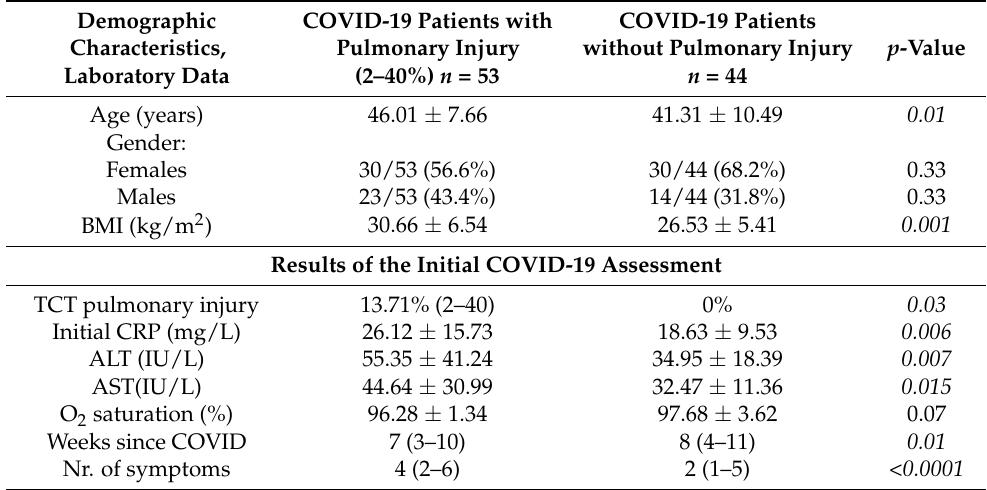
and severity of the pulmonary